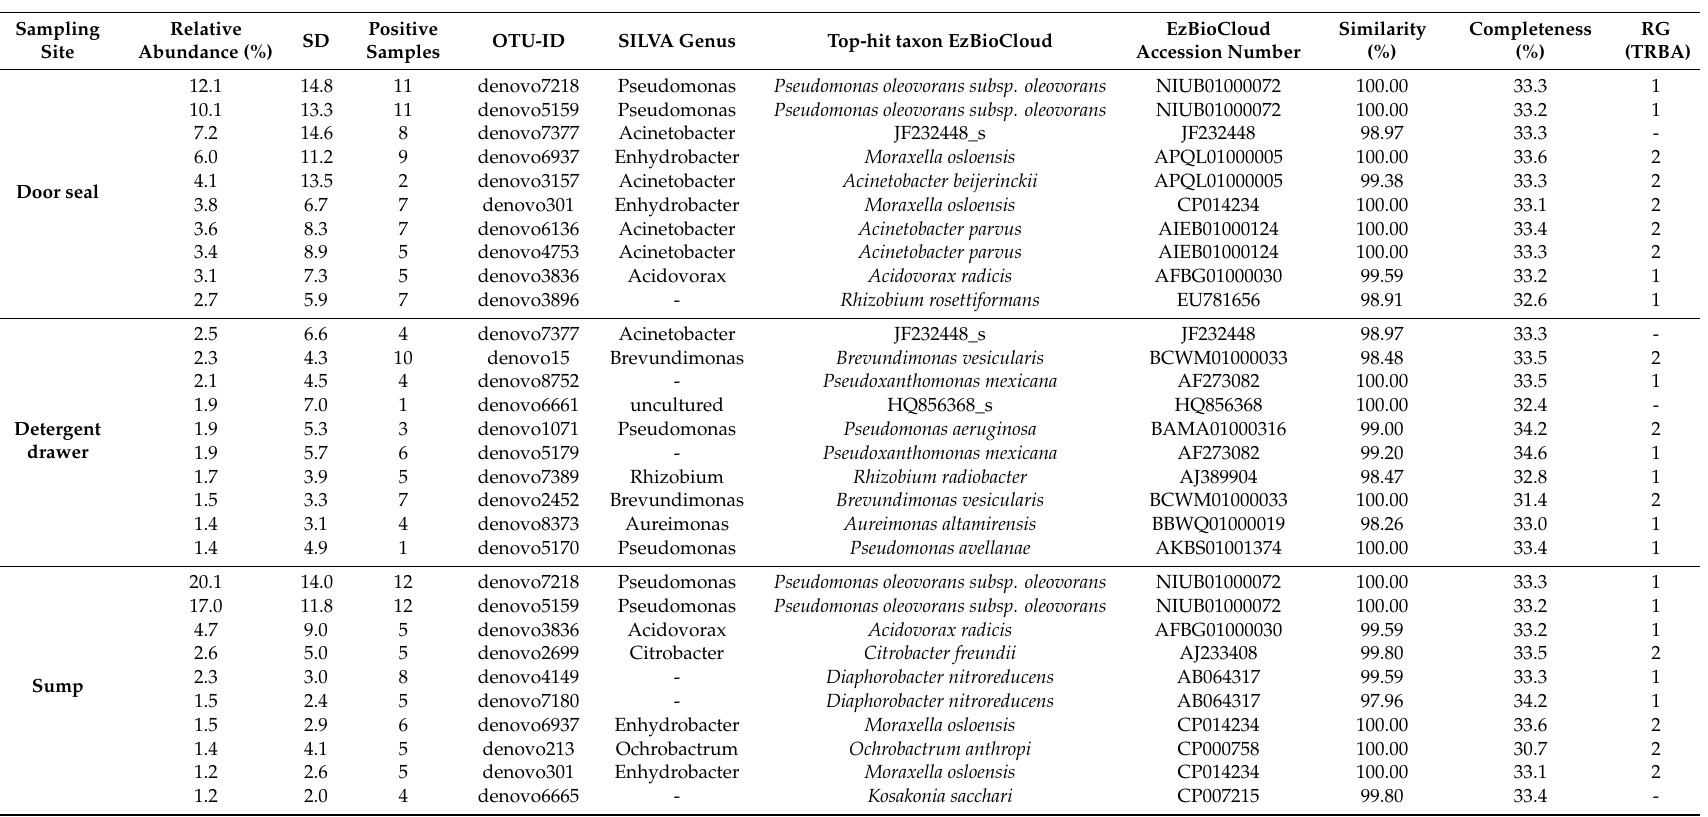
Table A1. Ten relatively most abundant OTUs per sampling site. The ten relatively most abundant OTUs per sampling site were determined and aligned against the 16S rRNA gene sequence database of EzBioCloud to calculate sequence similarities to known species. For each EzBioCloud match, sequence similarity and completness values are displayed. The identified top-hit taxa were also categorized into risk groups (RG) according to the German TRBA 466 [40]. SD = standard deviation. Positive samples = number of samples in which the OTU was